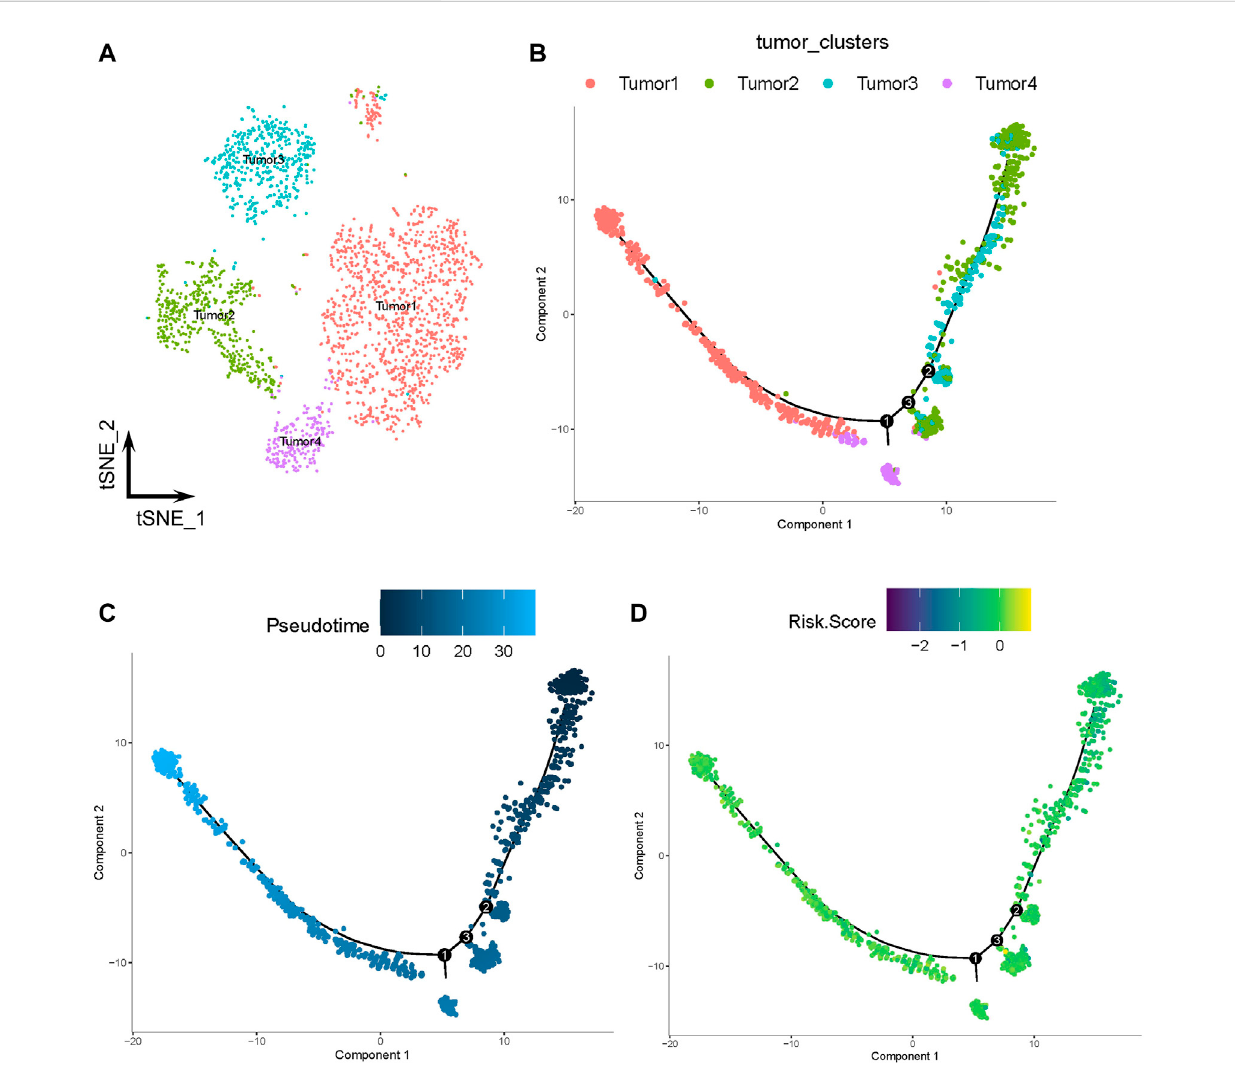
FIGURE 7 Pseudotime and trajectory analyses of tumor cells. (A) The t -distributed stochastic neighbor ( t -SNE) plot of four clusters of tumor cells. (B, C) Tendency curve from tumor 2 and tumor 3 clusters to tumor 1 and tumor 4 clusters. The y -axis shows the value of principal component 1 (the fi rst principal direction of maximum sample change) and x -axis shows the value of principal component 2 (second principal direction of maximum sample change). (D) Expression pro fi les of risk scores annotated in pseudotime and the trajectory plot.